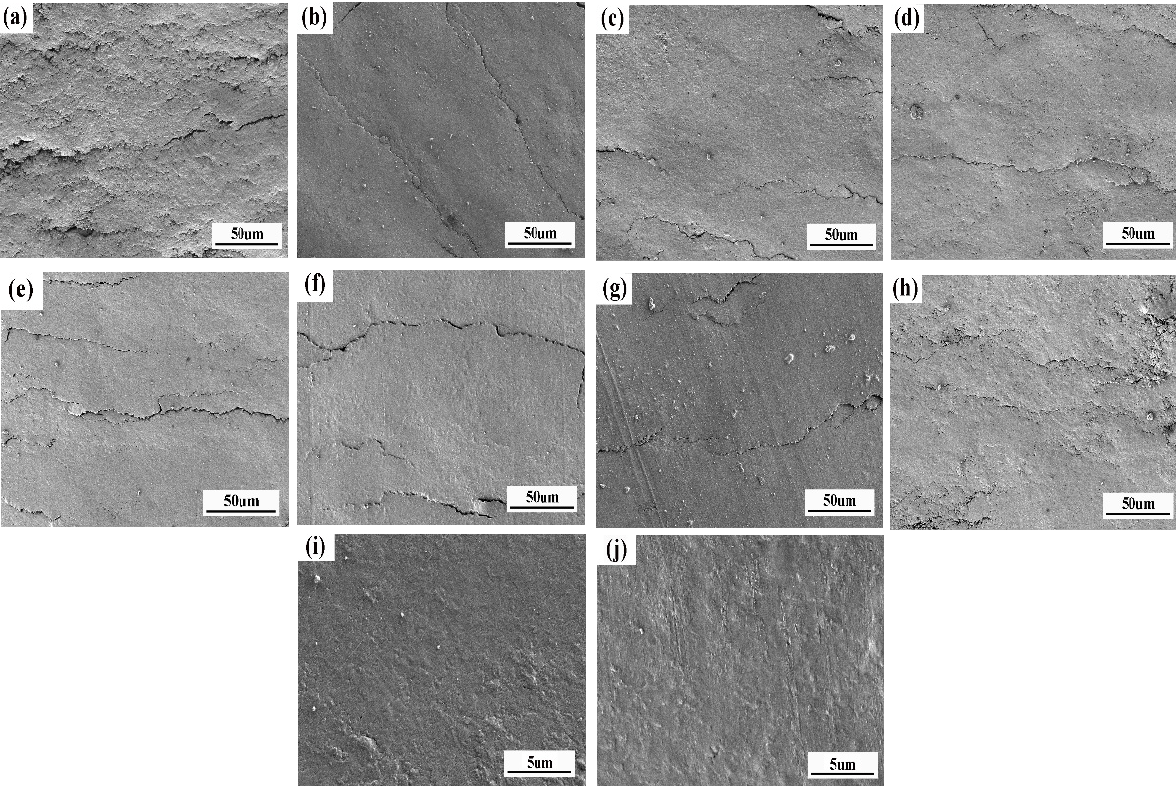
Figure 9. SEM images of wear track on the composites EP ( a ); S0 ( b , i ); S1 ( c ); S2 ( d ); S3 ( e ); S4 ( f , h , j ); S5 ( g ). The load of S4 ( h ) is 80 N, while the others are 60 N.